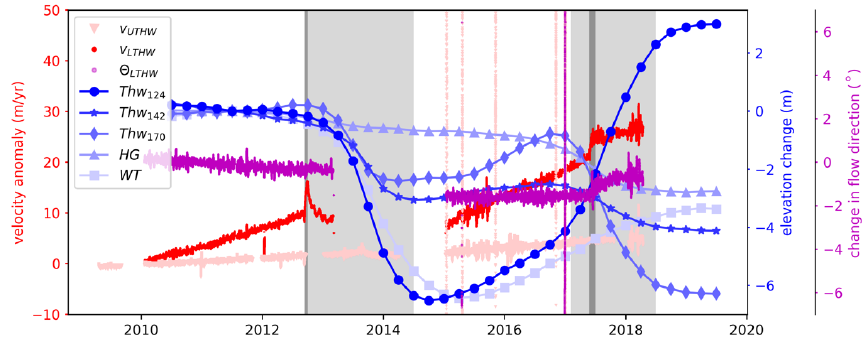
Figure 3. Time series of GNSS velocity anomalies at UTHW and LTHW corrected for advection using the Eulerian velocity products and CryoSat-2 lake elevation change averaged over each lake area. See Fig. 1 for site locations and abbreviations. Also plotted are LTHW GNSS clockwise direction change relative to 2010 flow direction (purple). The dark grey shaded periods indicate intervals when the LTHW GNSS accelerated significantly (99% confidence), while the light grey periods indicate when the Thw 124 , 142 , 170 lakes are active. When the largest lake fills in 2017, the LTHW GNSS closest to the lake accelerates and flows towards the